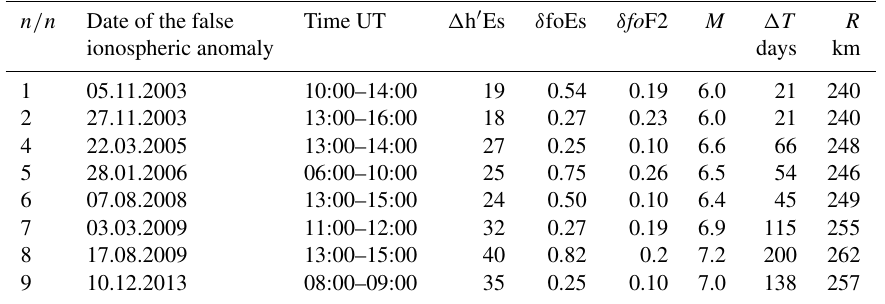
Table 4. Revealed false ionospheric anomalies for quiet periods between 2003 and 2015 along with calculated M , (cid:49)T , R values using the relationships (1–3). Only expected events with M ≥ 6 . 0 are listed.